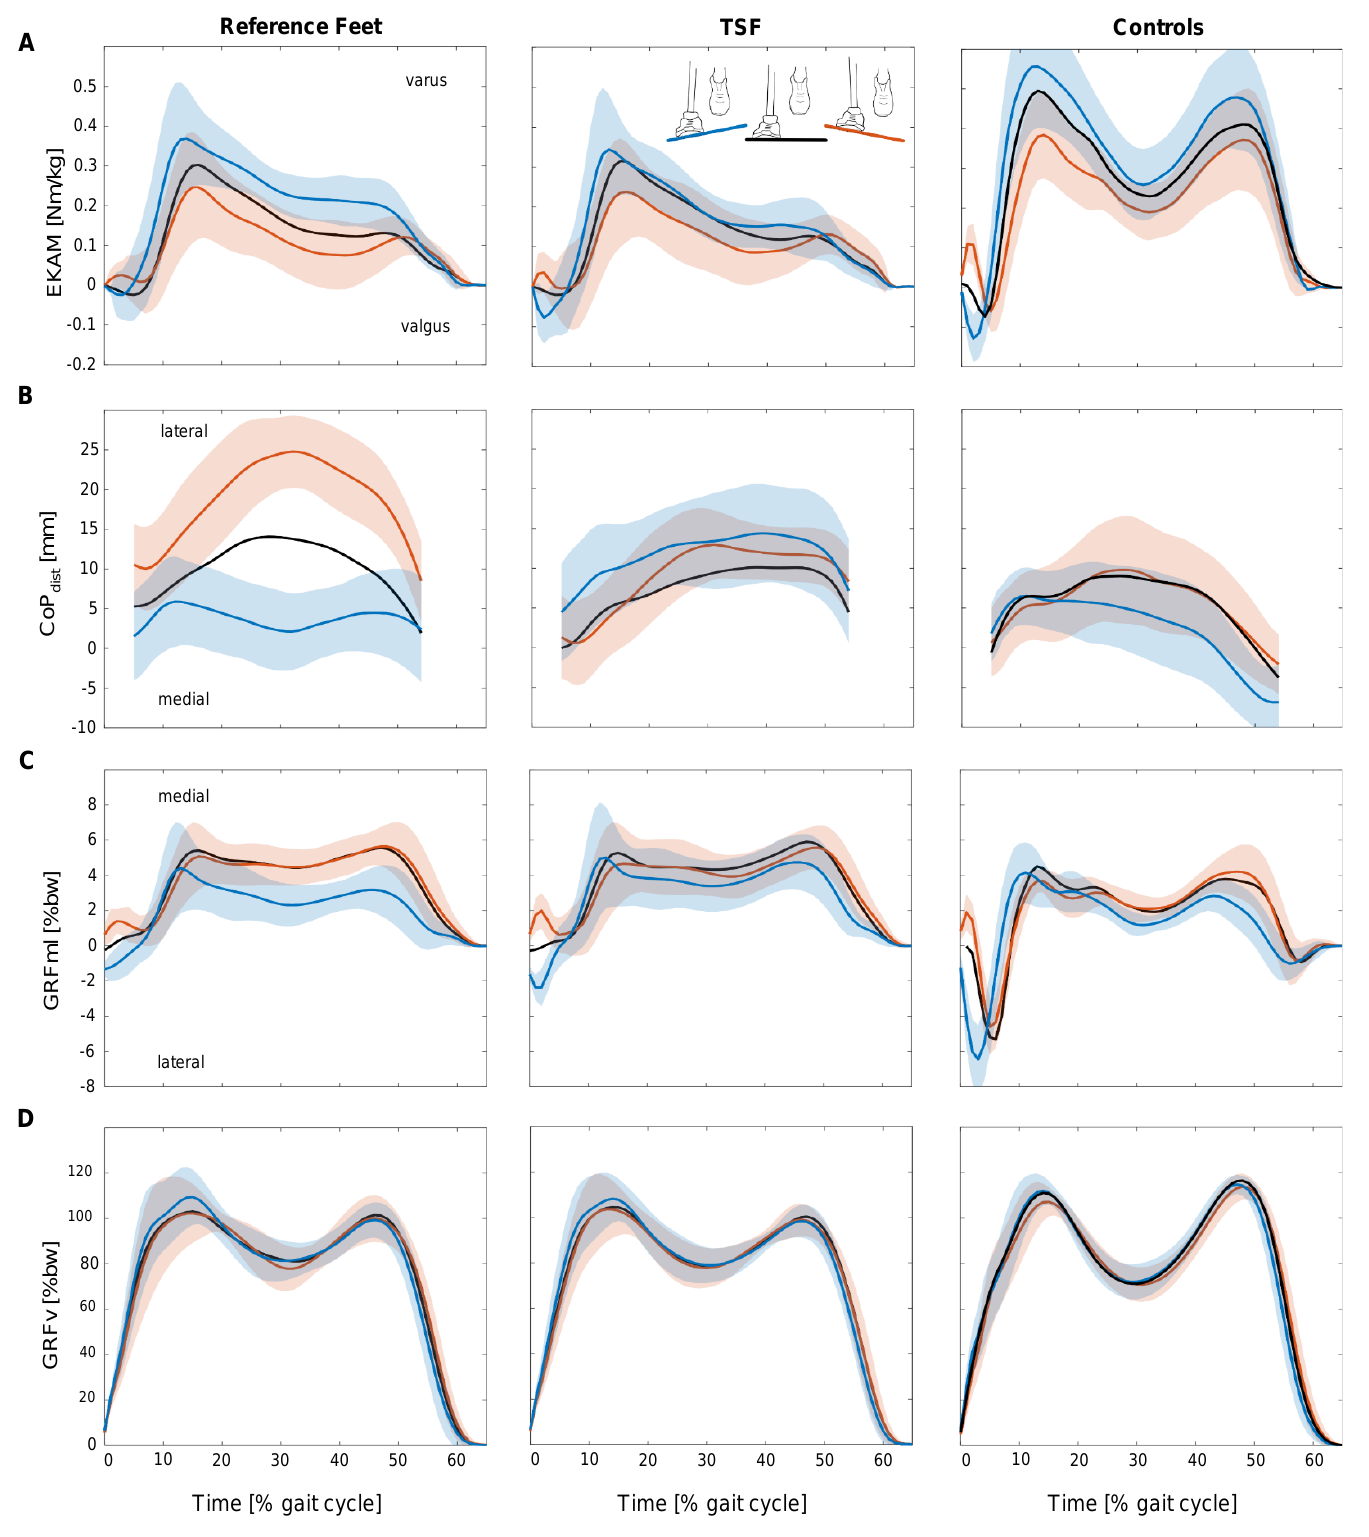
Figure 4: Parameters for the different studied situations. ( A ) EKAM, ( B ) mediolateral CoP course, ( C ) mediolateral ground reaction forces and ( D ) vertical ground reaction forces. The left column shows the prosthetic side values for the reference feet, the middle column the prosthetic side values for the TSF foot and the right column show the control subjects. The blue curves indicate the valleyside situations, the red curves indicate the hillside situations and the black curves indicate level walking. The associated standard deviations are given as shared areas for the blue and red